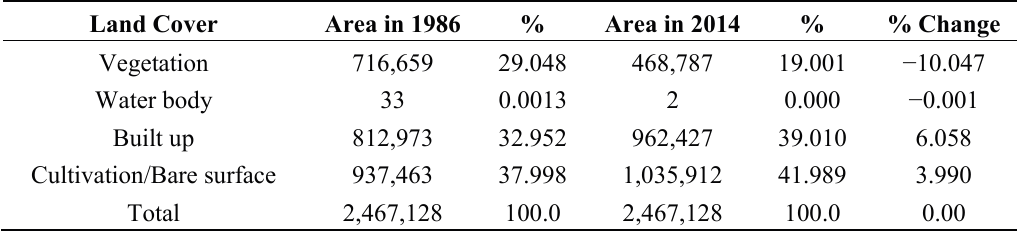
Table 2. Landcover change in Kafachan.